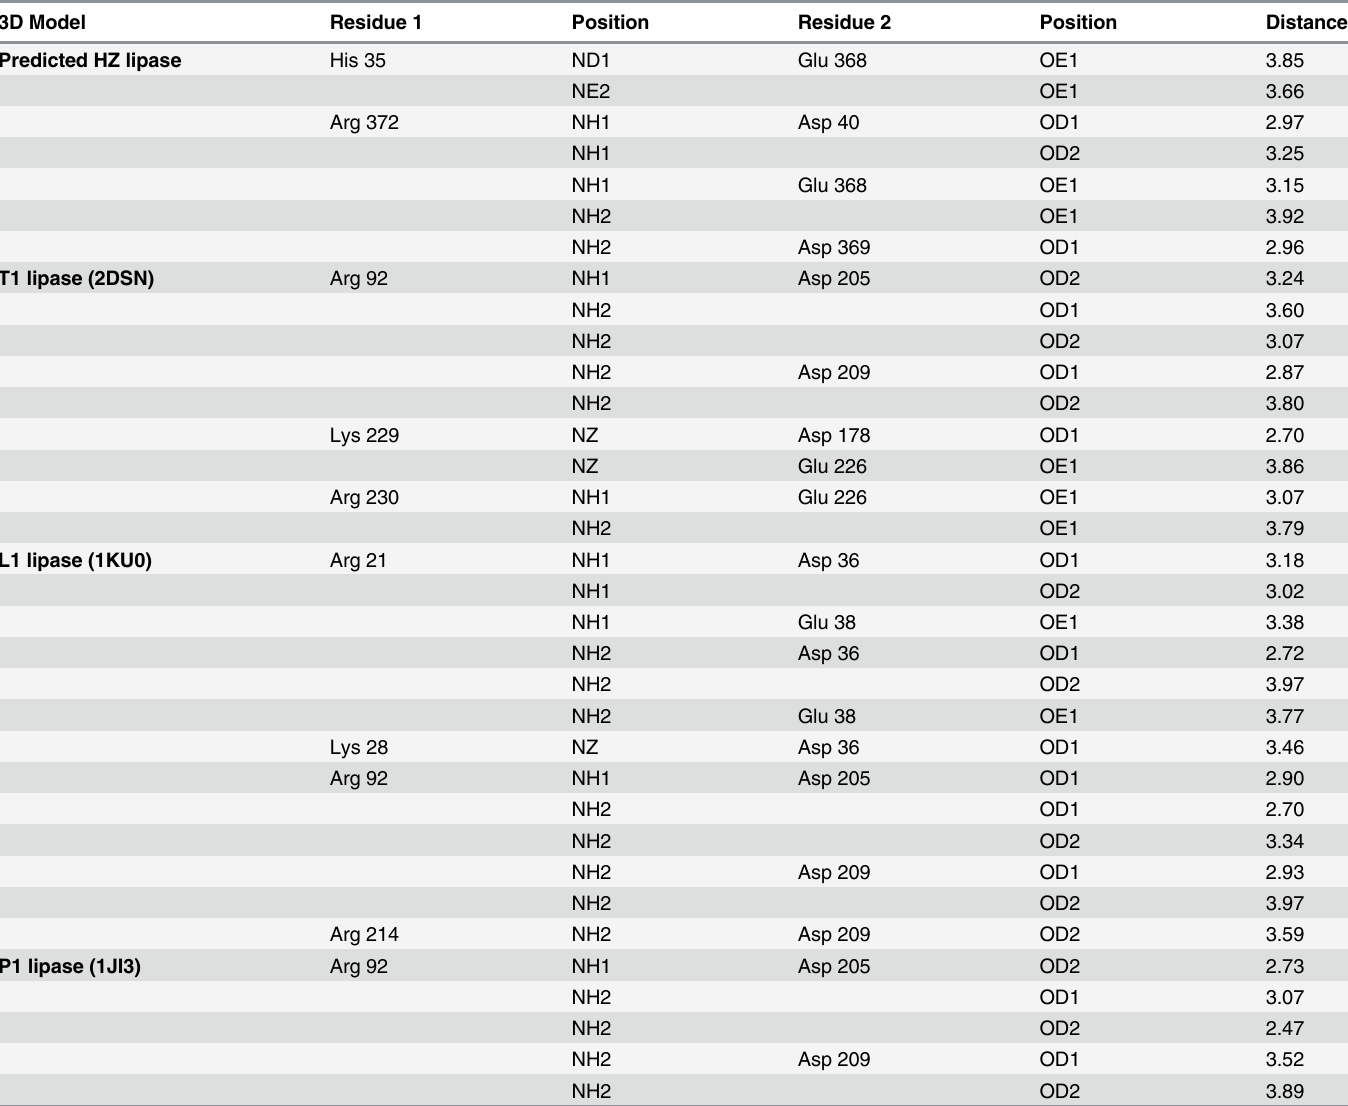
Table 3. The number of charged residues involved in ion-pair network formation in Predicted model of HZ and its templates structure. 3D